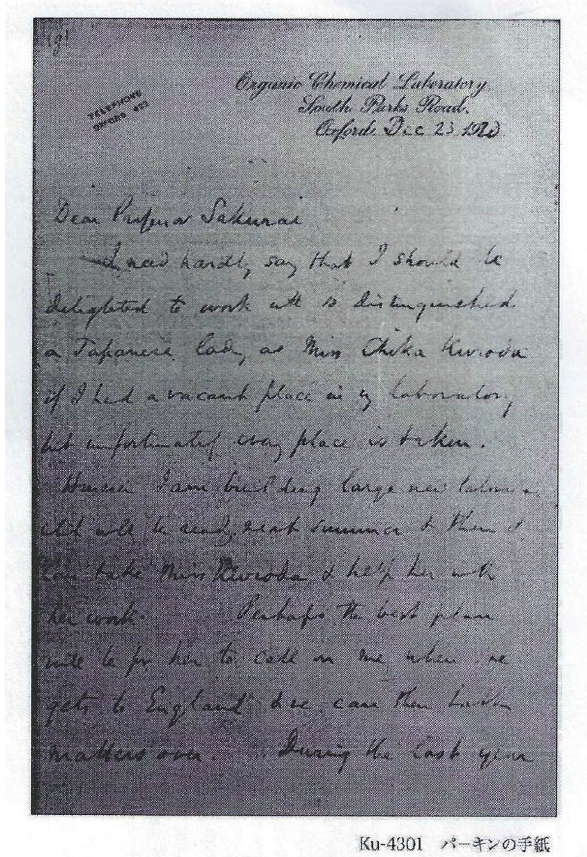
Figure 14. (Ku- 4301), W. H. Perkin Jr.’s Letter to Professor J. Sakurai concerning Kuroda Chika. December 23